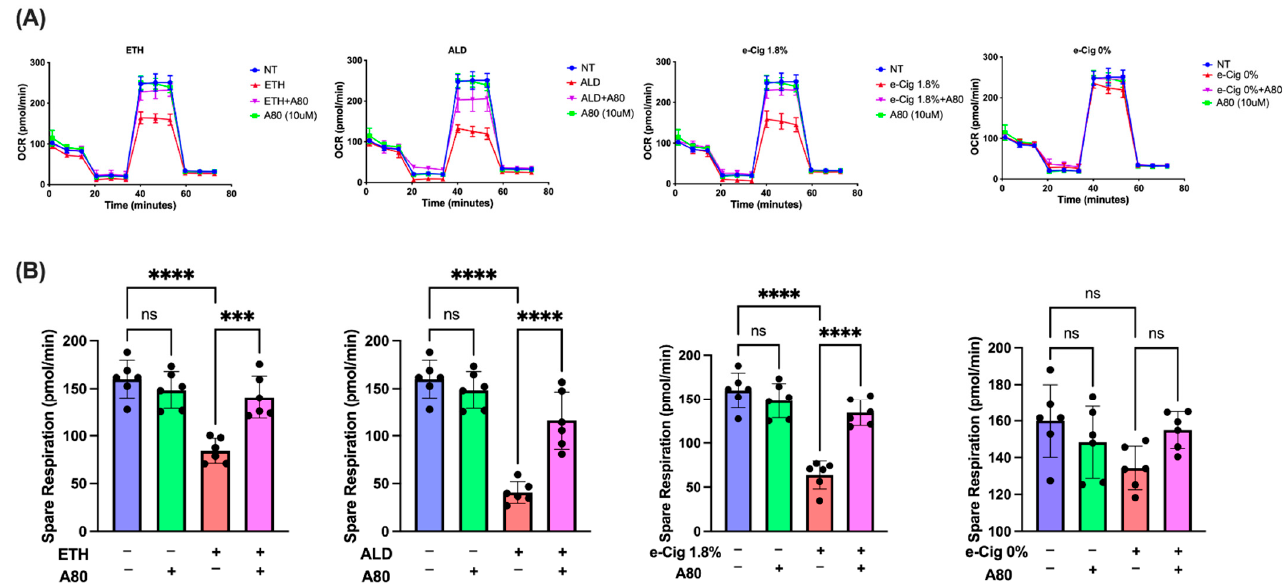
Figure 1. Mitochondrial OXPHOS levels diminished by ETH, ALD or 1.8% e-Cig exposure were restored by P2X7r antagonist. Mitochondrial SRC levels were measured after overnight exposure to ETH, ALD, and 1.8% e-Cig conditioned media. ( A ) shows the mito-stress graphs against ETH, ALD, and e-Cig (1.8%, 0% nicotine) stimulation. We quantified mitochondrial spare respiration (SRC) by subtracting basal respiration from the maximal respiration. ( B ) After overnight incubation, we recorded a 50% reduction in spare respiration against ETH exposure, 75% reduction against ALD, and 60% decrease after treatment with1.8% e-Cig containing media. Although SRC levels in cells treated with 0% e-Cig stimulus show a similar pattern, changes in SRC levels were not significant. Cells treated with P2X7r antagonist A804598 restored the SRC levels against ETH, ALD, and 1.8% e-Cig stimuli ( n = 6). We normalized the Seahorse data to untreated control cells and One-Way ANOVA was used for statistical analysis, marked as *** p ≤ 0.001, **** p ≤ 0.0001 and ns (not significant).